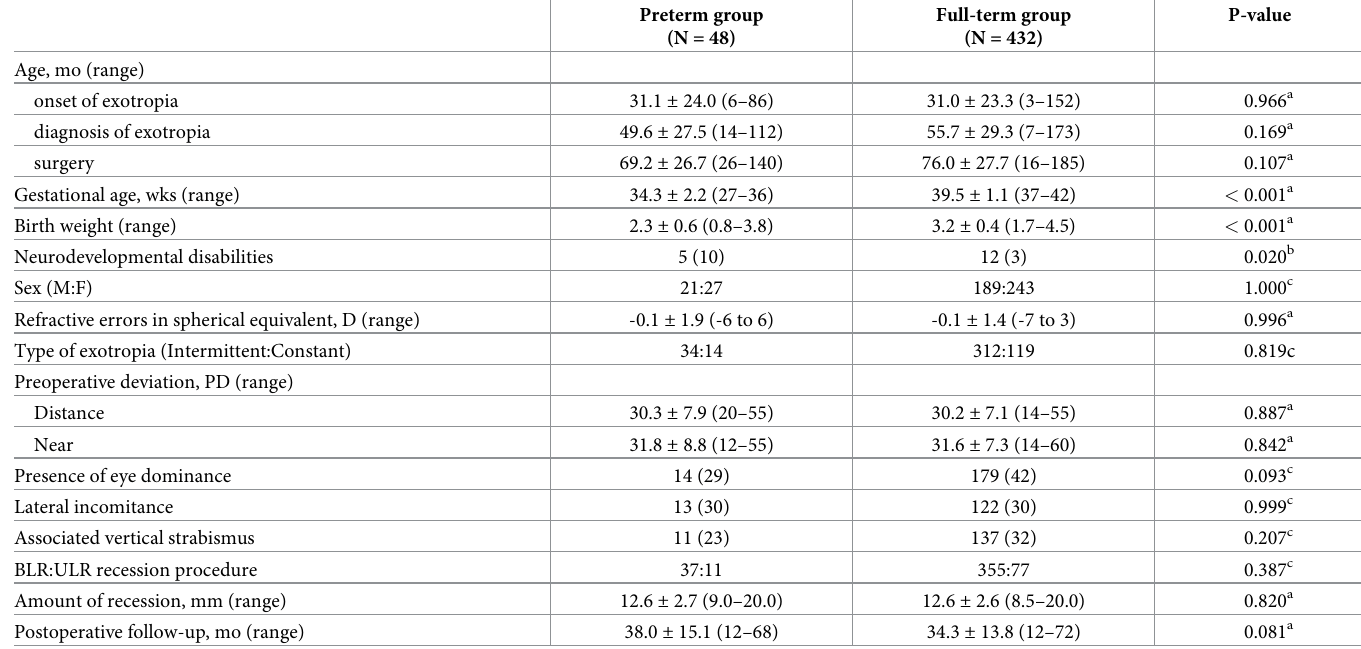
Table 2. Demographics and ocular characteristics of